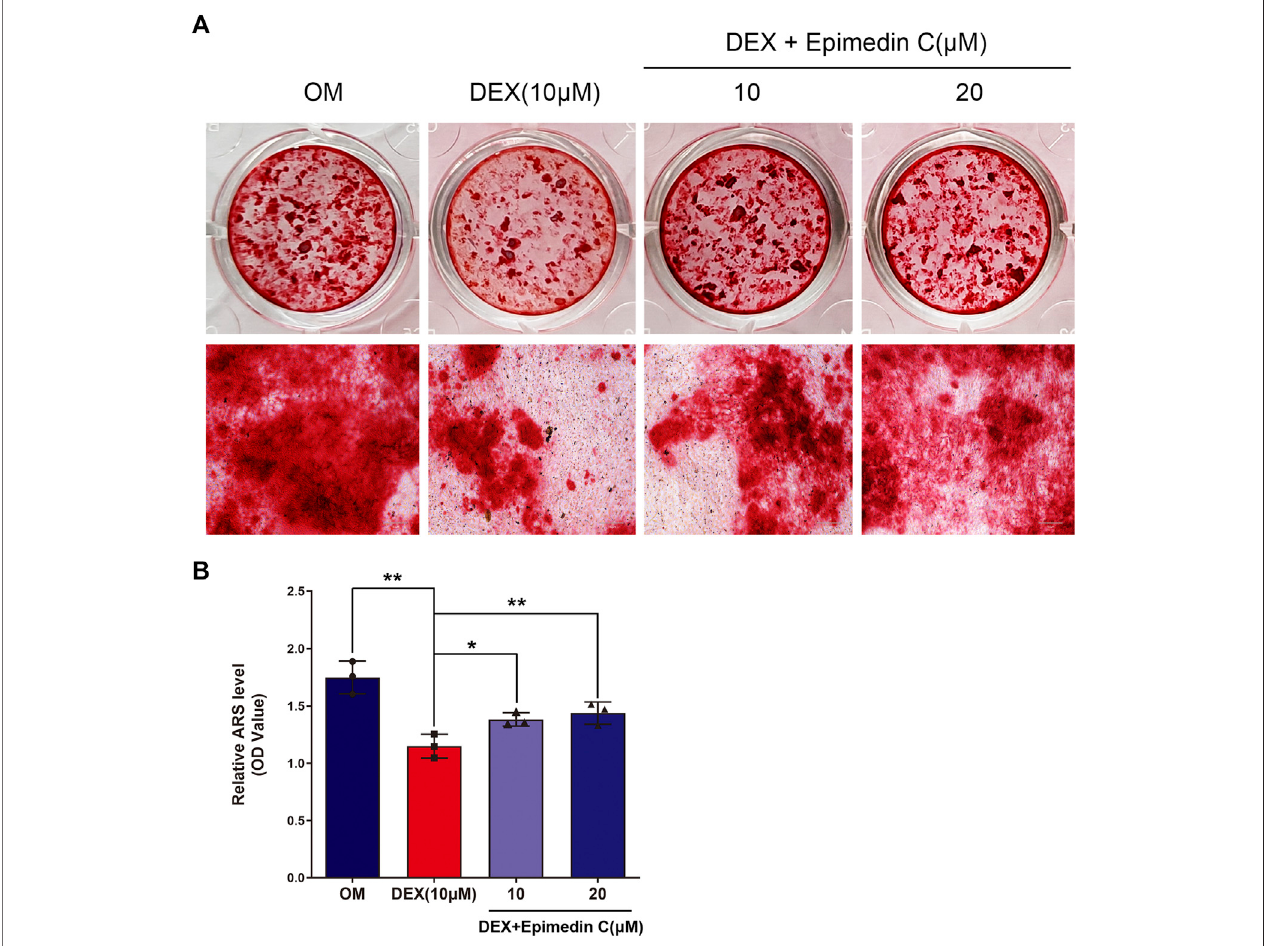
FIGURE 3 | Epimedin C attenuated the inhibiting impact of DEX on mineralization in MC3T3-E1 cells. (A) Upon MC3T3-E1 cells treatment using epimedin C and DEX in OM for 21 days, alizarin red S was utilized for staining the mineralized nodules. (B) Isolation of alizarin red S dye with 10 percent CPC was carried out to quantify the mineralization status. DEX: dexamethasone, OM: osteogenic induction medium. *p < 0.05, **p < 0.01.